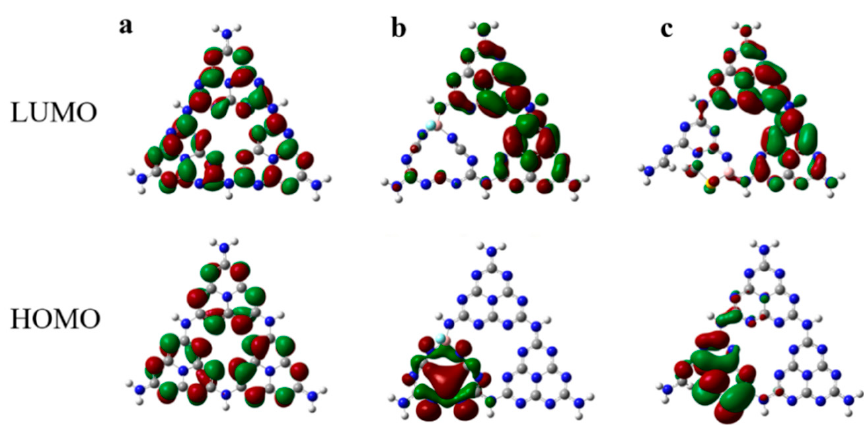
Figure 4. HOMO and LUMO for g-C 3 N 4 ( a ), B-F-N v ( b ), and B-S-N v ( c ).